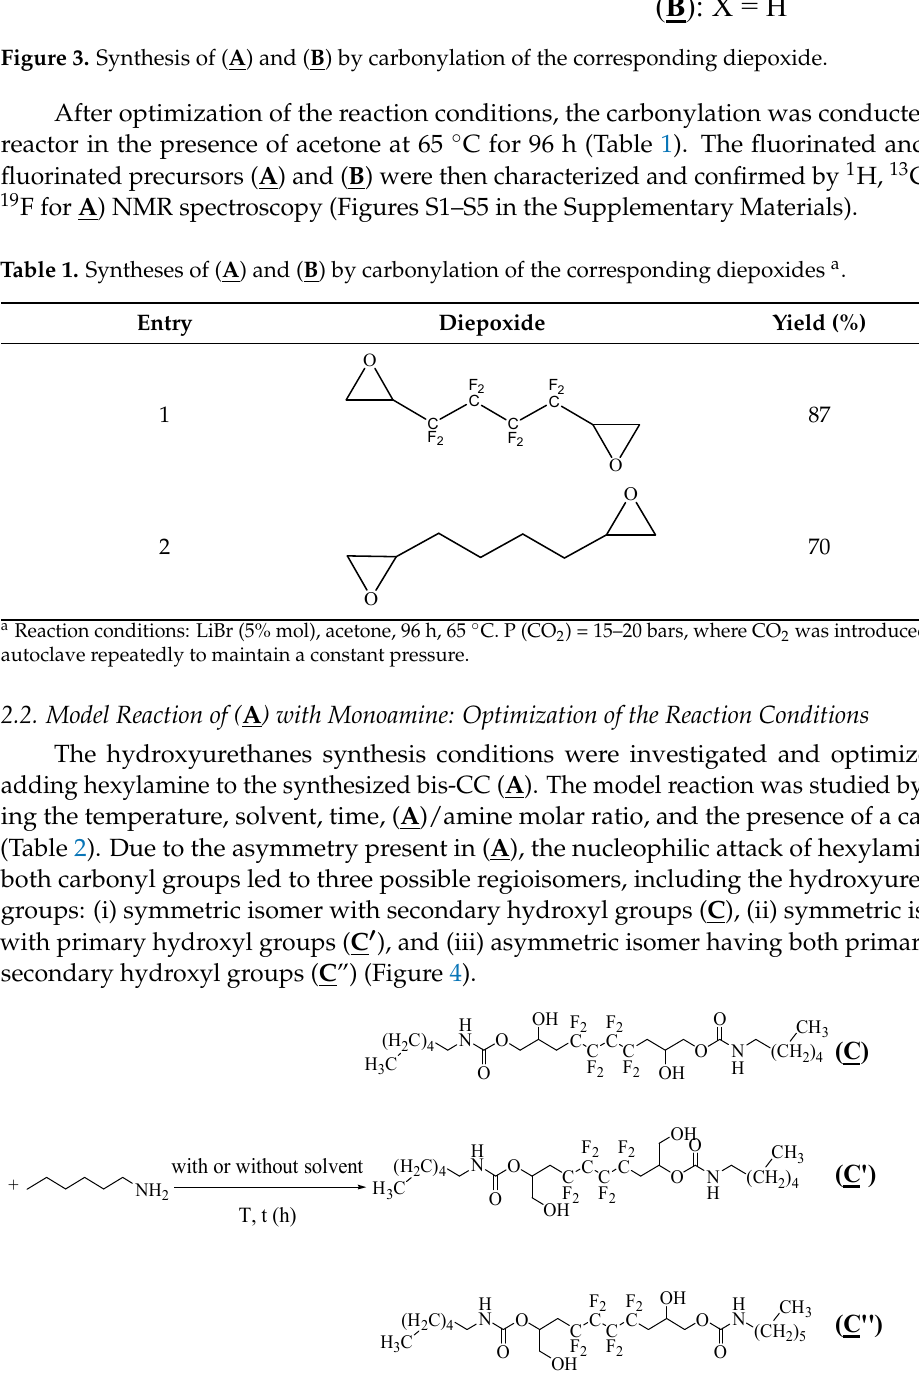
Figure 4. Synthesis of three possible regioisomer hydroxyurethanes by addition of hexylamine to ( A ). Table 2. Model reaction of ( A ) with hexylamine a : conditions optimization .